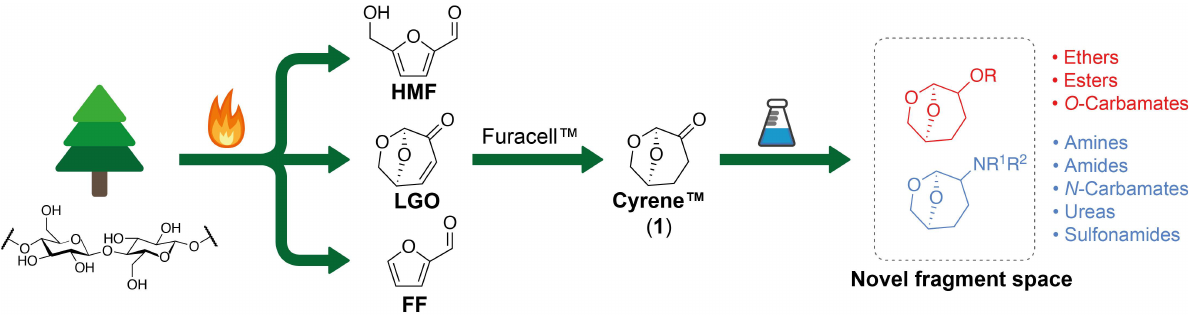
Figure 1. The approach pursued in this work. Pyrolysis of cellulose/wood gives, among others, LGO, which has become readily available as its reduced analog Cyrene. Functionalization of Cyrene with an array of functional groups provides a set of O - and N -substituted “green